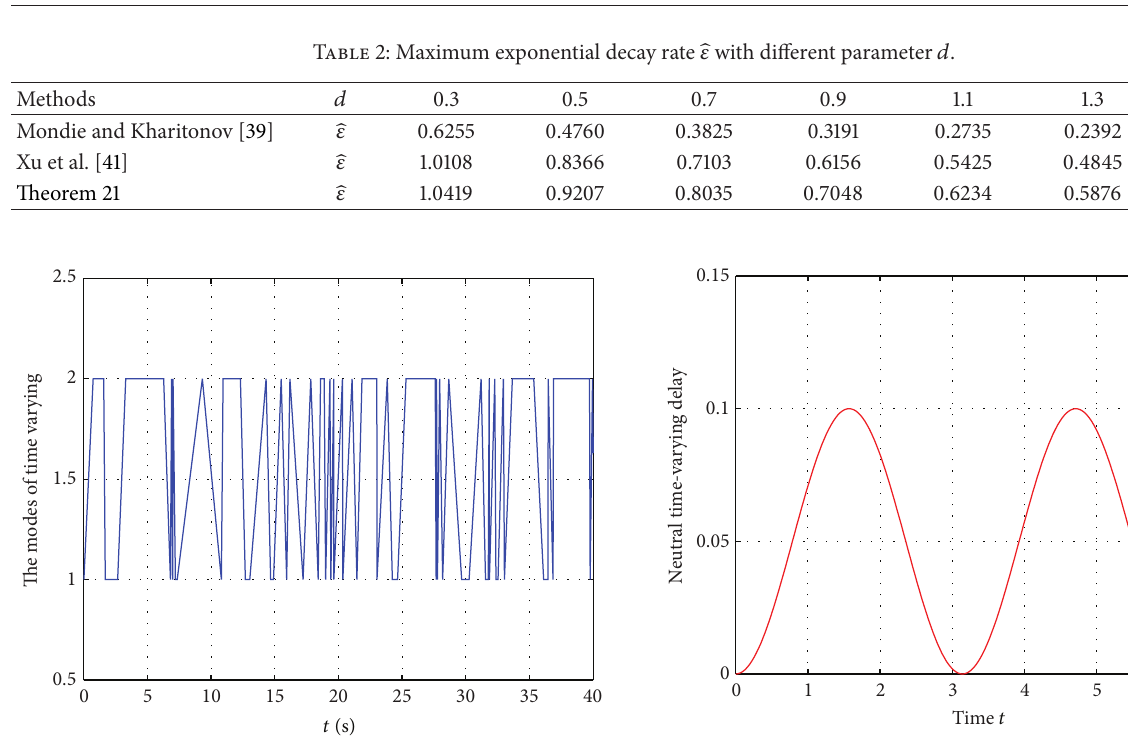
Figure 1: The mode switching of Example 1. Figure 2: Interval time-varying neutral delay